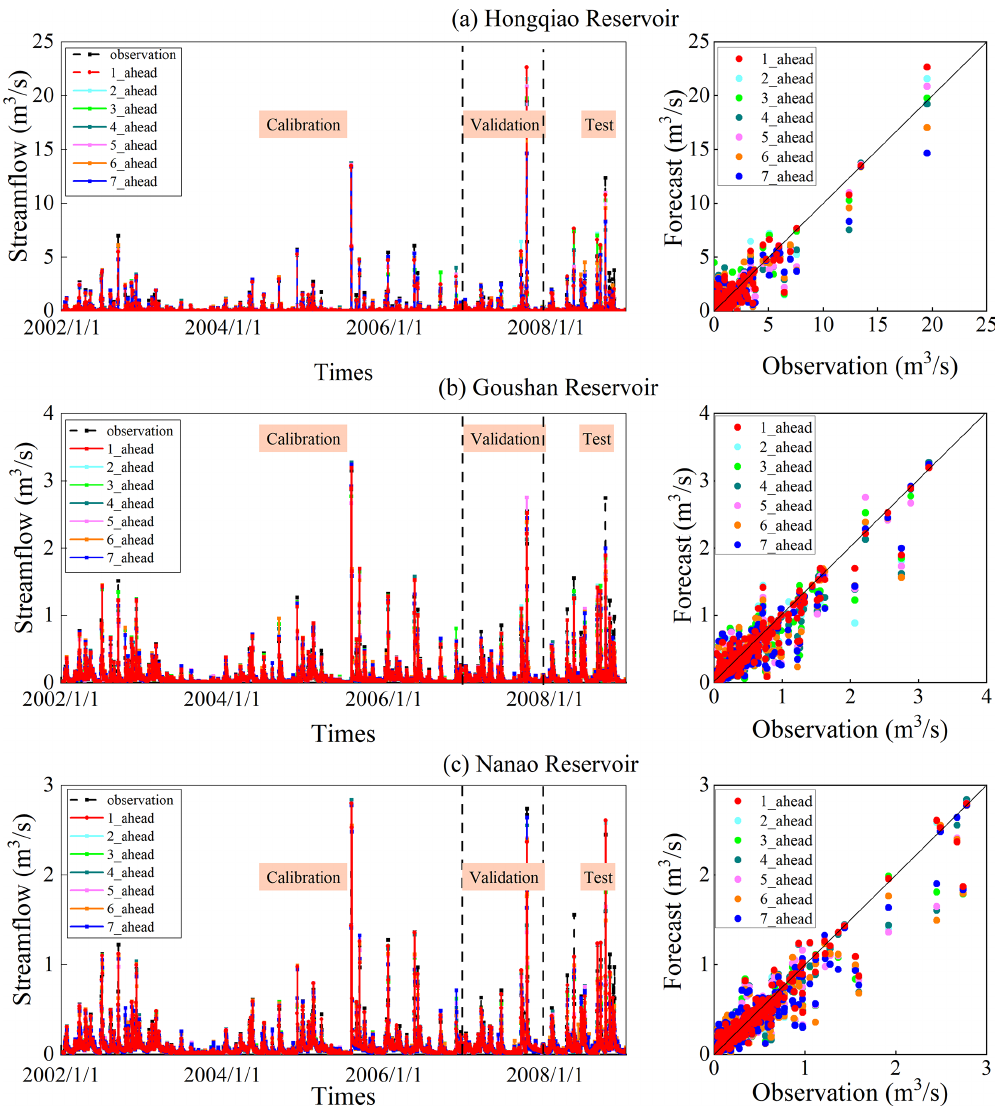
Figure 11. Forecast results of (a) Hongqiao, (b) Goushan, and (c) Nanao reservoirs under